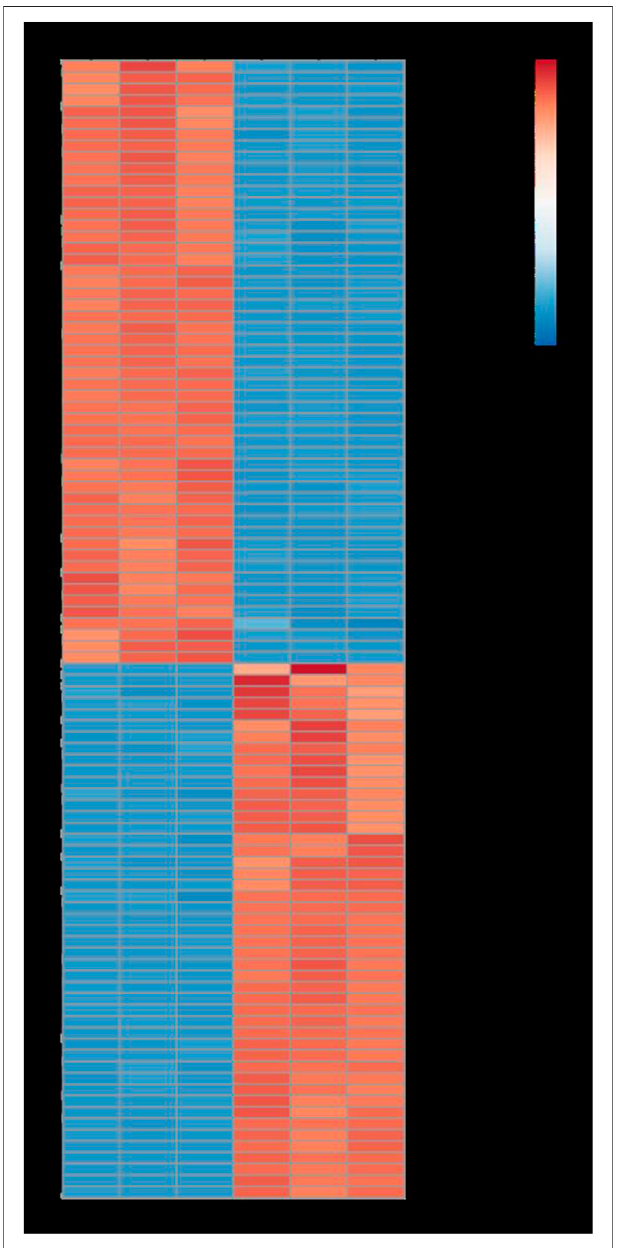
FIGURE 8 | Heatmap analysis describing the differentially expressed genes. Red, up-regulated genes. Blue, down-regulated genes.